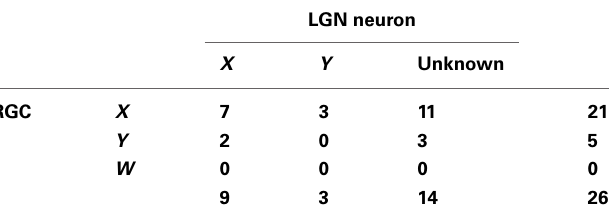
Table 1 | Cell types for the retinogeniculate